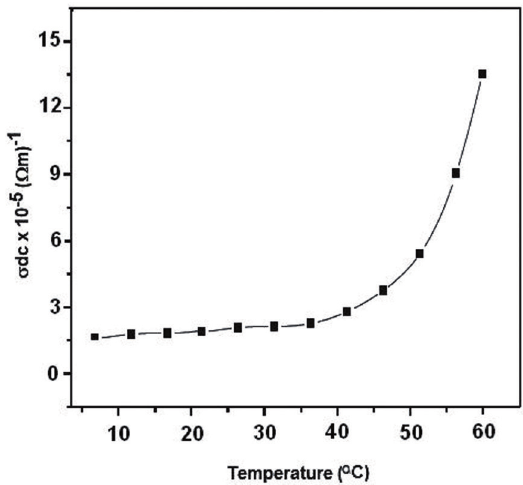
Figure 8: Variation of dc conductivity versus